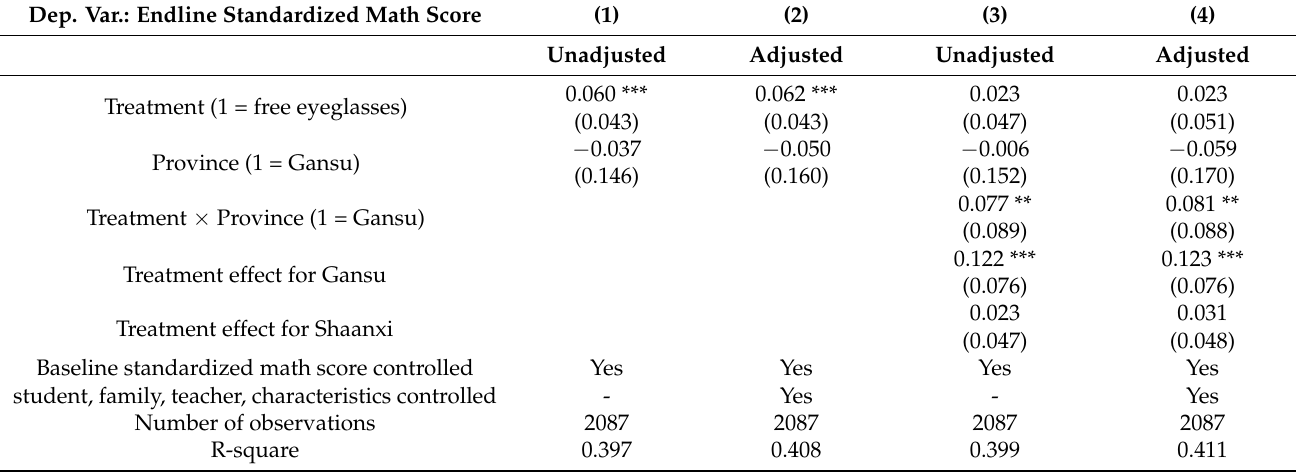
Table 2. Impact of providing eyeglasses on endline standardized mathematics score